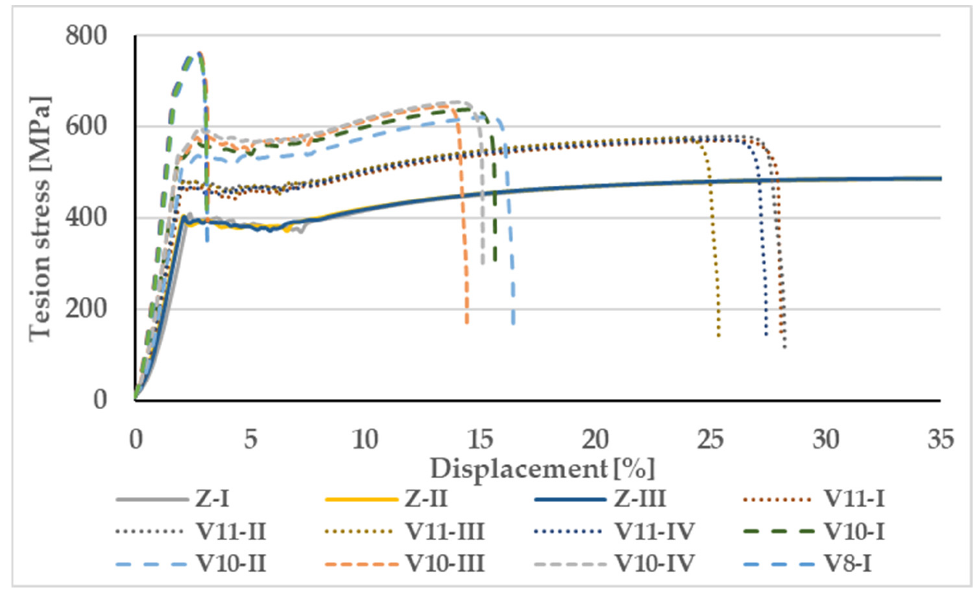
Figure 22. Dependence of stresses and deformations due to different notch depths—reinforcement ϕ 12 mm of steel S355.